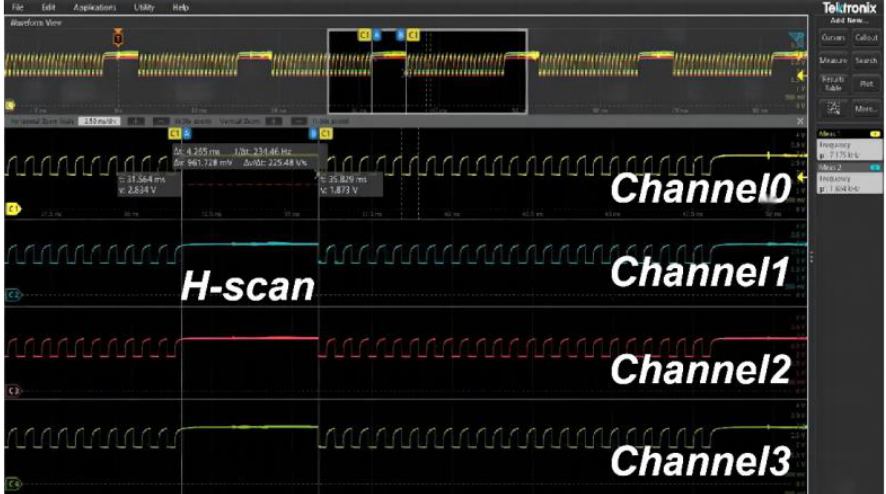
Figure 9. Measurement results of different channels in dimmer.